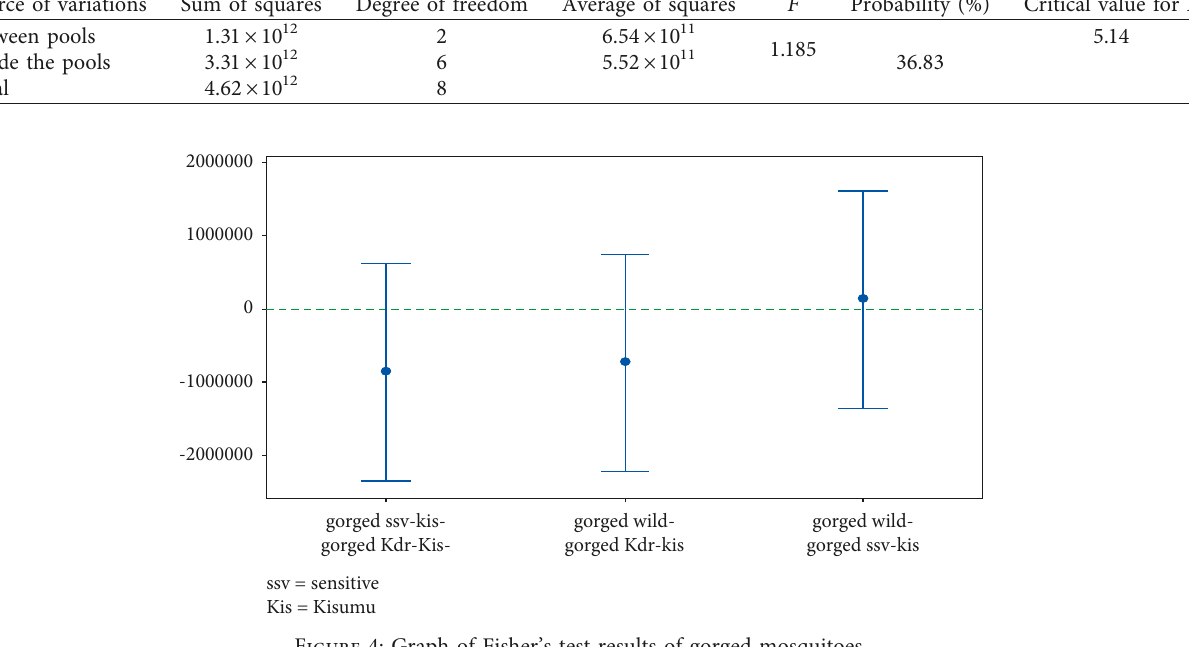
Table 3: Results of the analysis of the variance test of the different batches of Anopheles gambiae mosquito in the gorged category. Source of variations Sum of